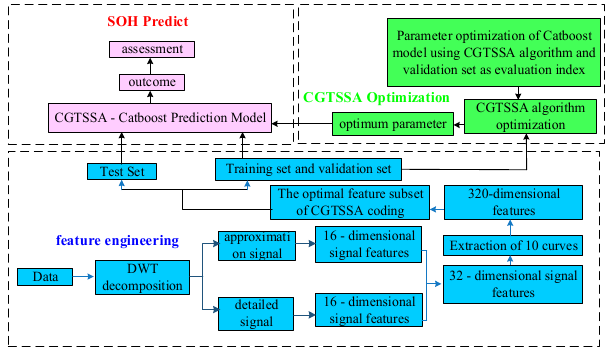
Figure 1. Multiscale health factor extraction and CGTSSA-CatBoost prediction model based on DWT.